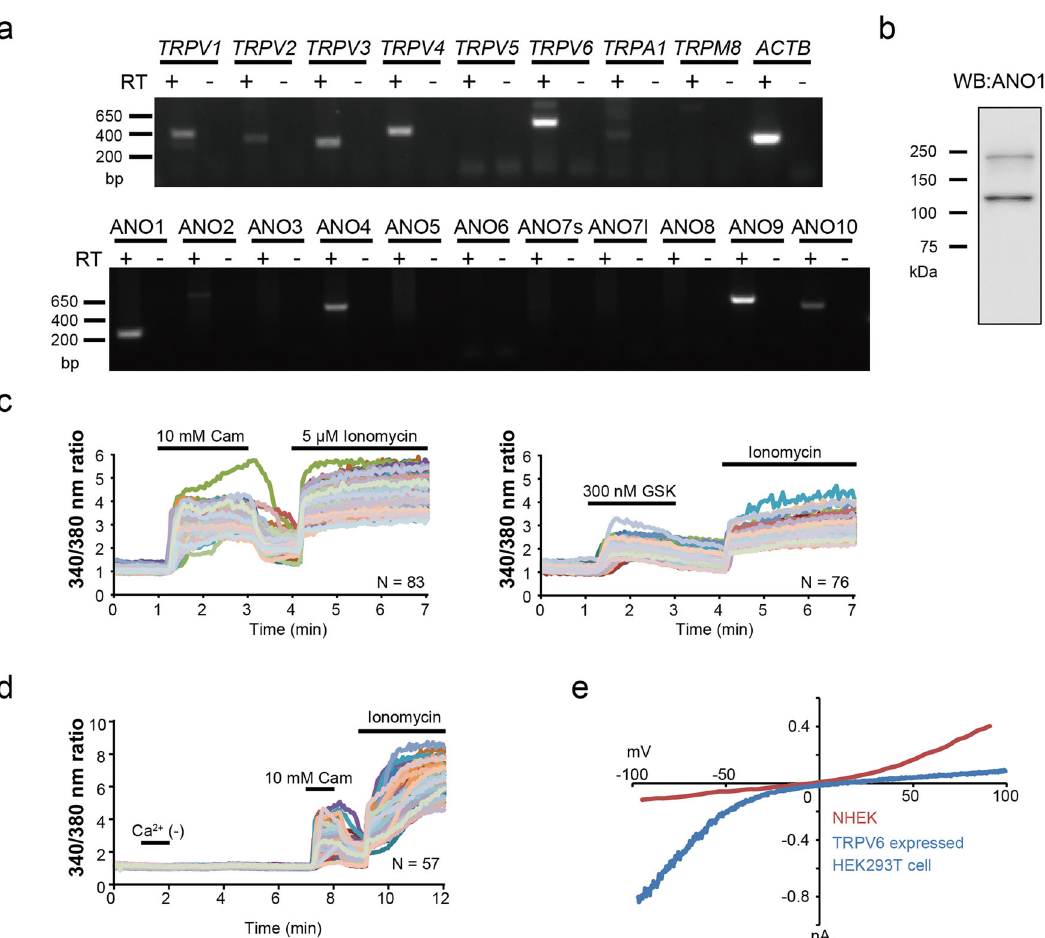
Fig. 1 TRP channels and ANOs expression in NHEKs. a RT-PCR of TRPs and ANOs in NHEKs. Uncropped gel images are shown in Suppl. Fig. 11. b Western blot of ANO1 in NHEKs. The predicted band size of ANO1 is 114 kDa. c , d Calcium imaging in NHEKs. Cam Camphor, a TRPV3 agonist; GSK GSK1016790A, a TRPV4 agonist; Ca 2 + ( − ) Calcium-free bath solution. e Comparison of current – voltage relationships. The red line indicates current – voltage relationship of basal current in NHEKs using a standard bath and pipette solution. The blue line indicates current – voltage relationship in TRPV6-expressing HEK293T cells using a standard bath solution and NMDG-Cl pipette solution. The holding potential was − 60 mV and ramp-pulses were applied from − 100 to + 100 mV for 300 ms duration every 5